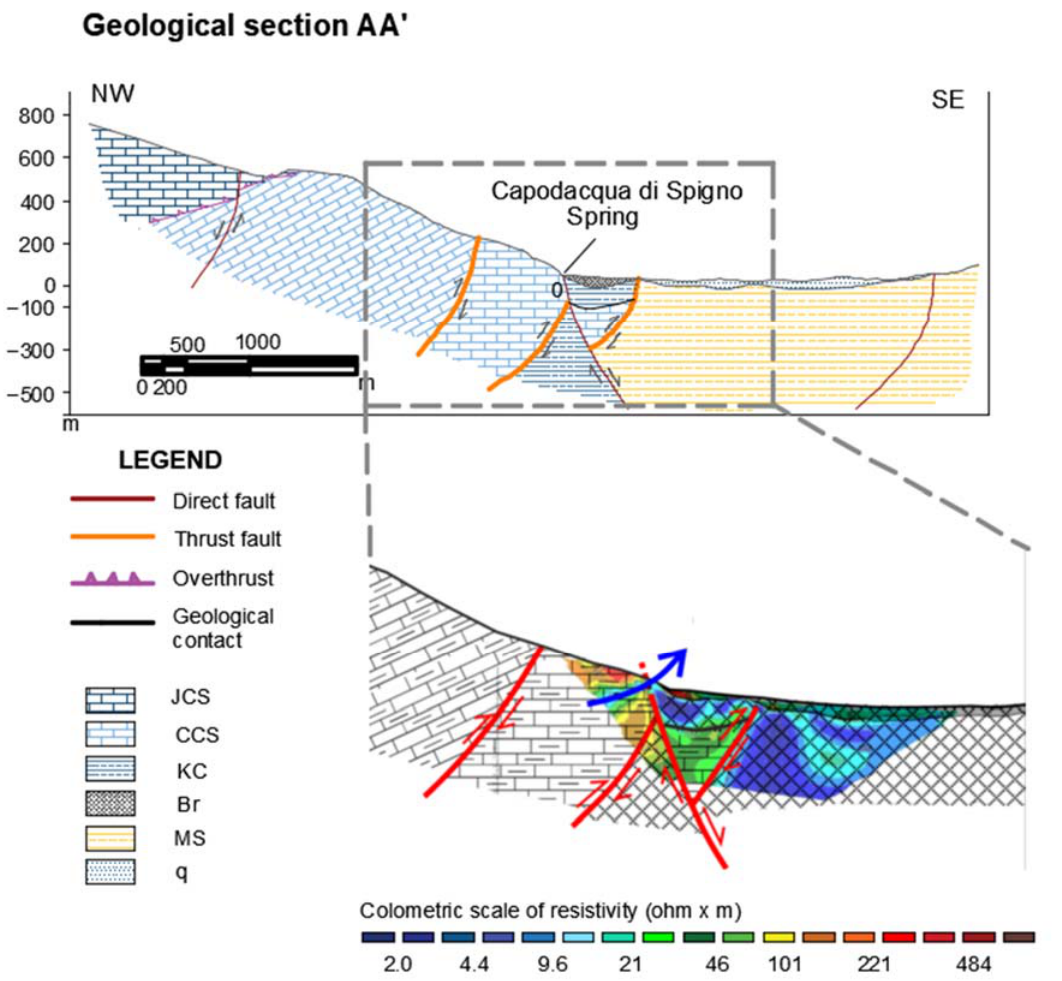
Figure 2. Geological section AA’ (trace in Figure 1) modified from the study of the geological map of Italy [29] and geological map edited by Baldi et al., 2005 [28]: the image below depicts the structural pattern by geoelectric tomography interpretation. Legend: JCS is Jurassic Carbonate Series; CCS is Cretaceous Carbonate Series; KC is Kaolinitic Clays; Br is Clutch Breach; MS is Miocene Series and q is Quaternary deposits.